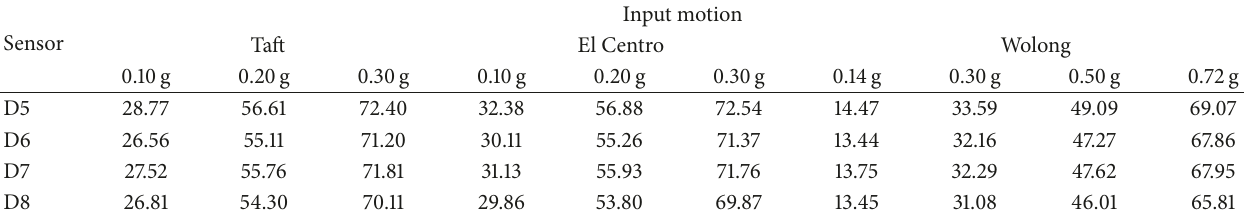
Figure 16: Relative displacement along structural height under Wolong records. Table 6: Displacement response of the model for different input motions (unit: